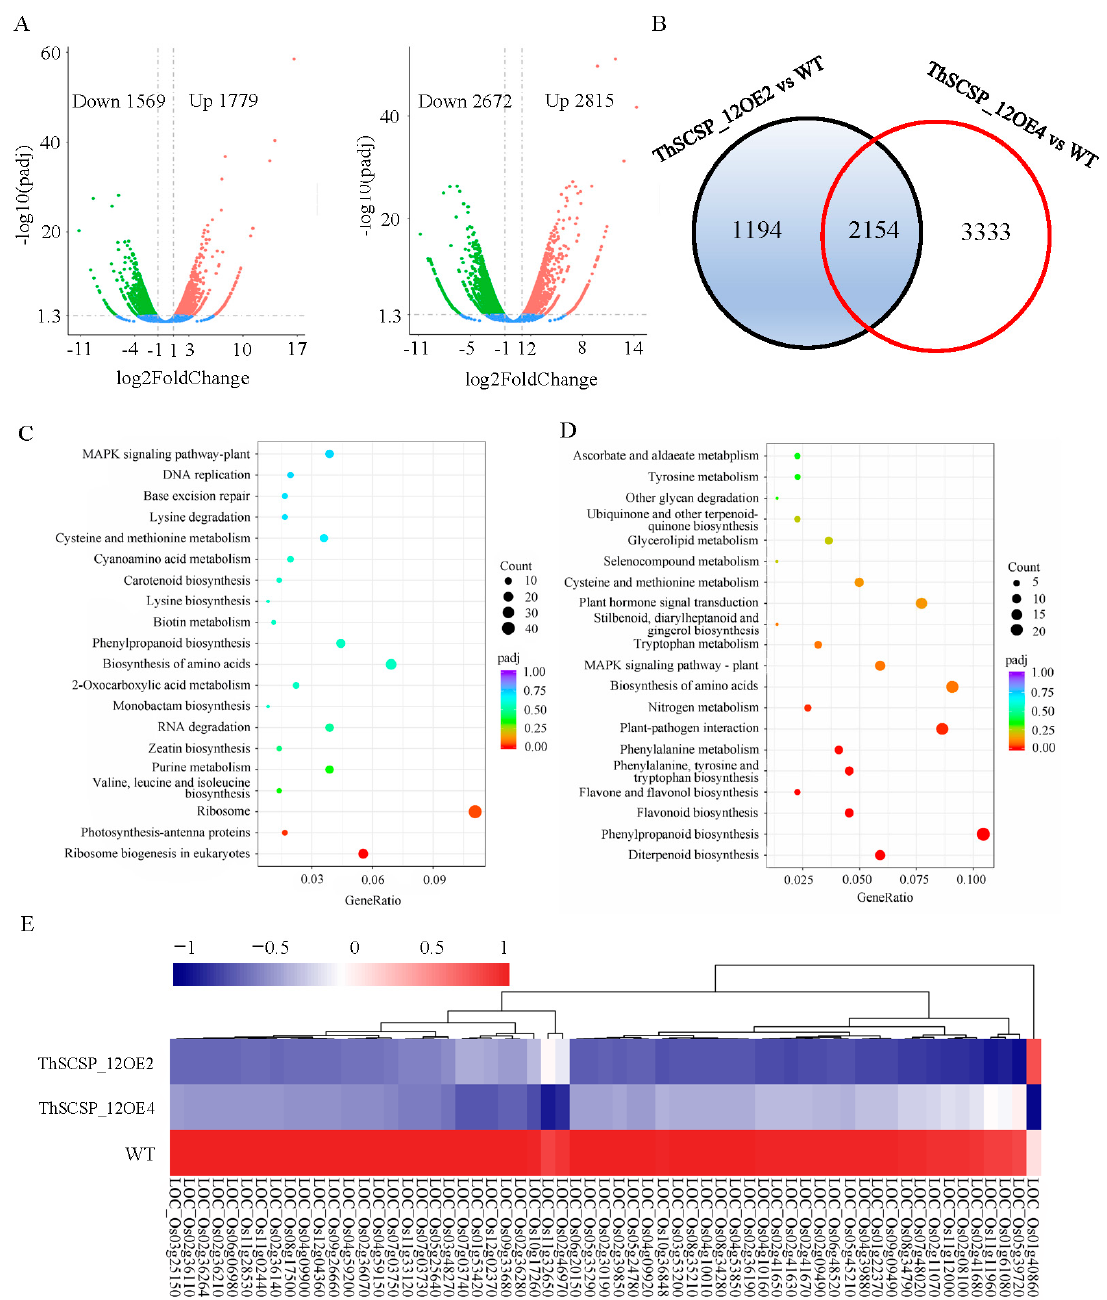
Figure 9. Analysis of RNA-seq data for the ThSCSP_12-OE and wild-type (WT) plants. ( A ) The number of differentially expressed genes (DEGs) in ThSCSP_12-OE2 and ThSCSP_12-OE4 plants compared with WT. ( B ) Venn diagrams showing the overlap of DEGs in ThSCSP_12-OE2 and ThSCSP_12-OE4 plants. ( C ) KEGG enrichment analysis of up-regulated DEGs in both ThSCSP_12-OE2 and ThSCSP_12-OE4 plants. For the dots, their size and color represent the number of DEGs and their adjusted p -value, respectively. ( D ) KEGG enrichment analysis of the down-regulated DEGs in both ThSCSP_12-OE2 and ThSCSP_12-OE4 plants. For the dots, their size and color represent the numbers of DEGs and the q-value, respectively. ( E ) Expression of DEGs enriched in the pathways for phenylpropanoid biosynthesis, diterpenoid biosynthesis, flavonoid biosynthesis, phenylalanine metabolism, and plant- pathogen interaction in the ThSCSP_12-OE2 and ThSCSP_12-OE4 plants. Four of those are involved in reactive oxygen metabolism and cell death.